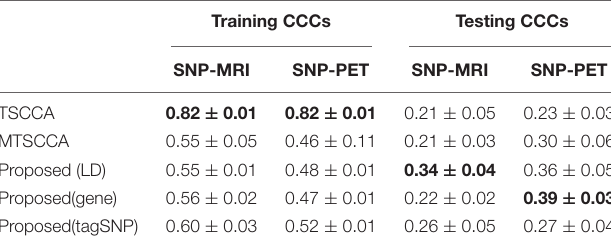
TABLE 3 | Comparison of canonical correlation coefficients (mean ± std) in terms of each model.